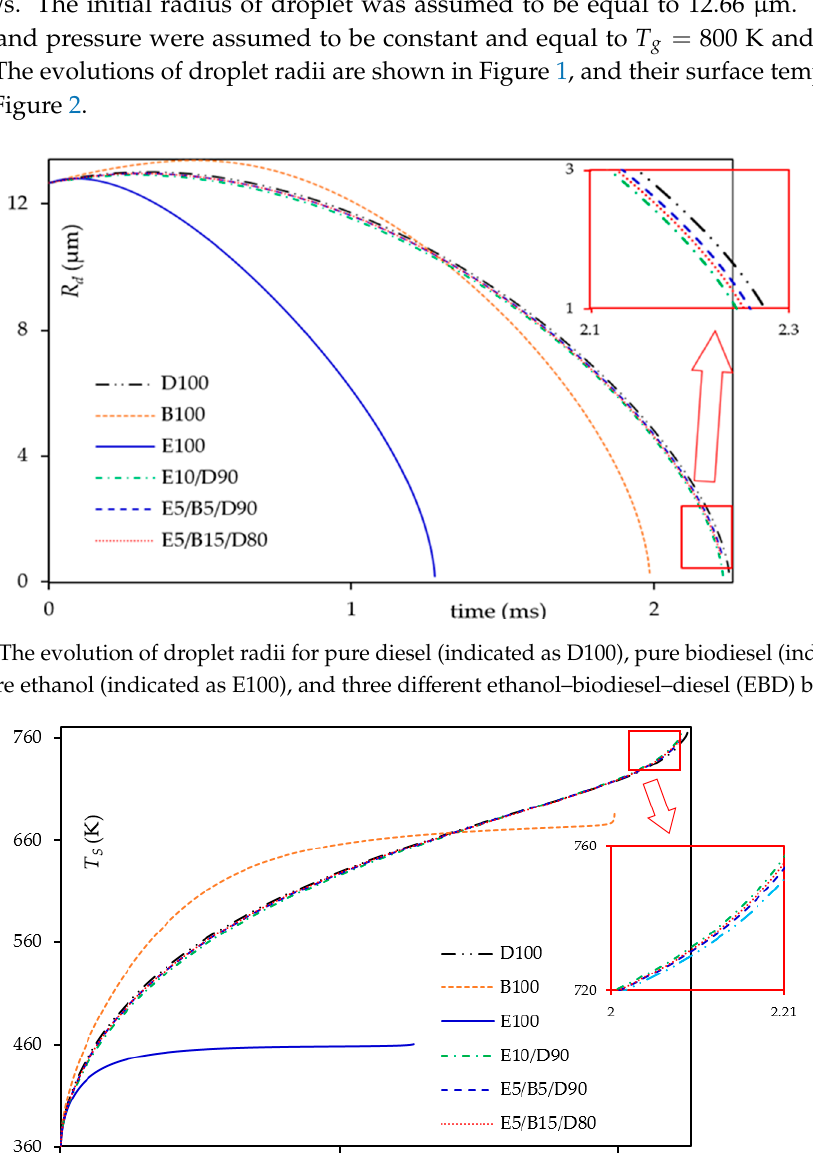
Figure 2. The evolution of droplet surface temperatures for the same fuels and their blends as in Figure 1.